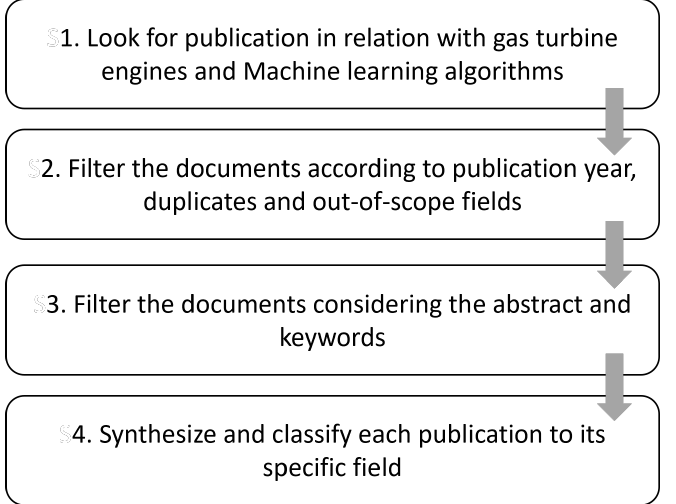
Figure 2. Methodology of research detailed step by